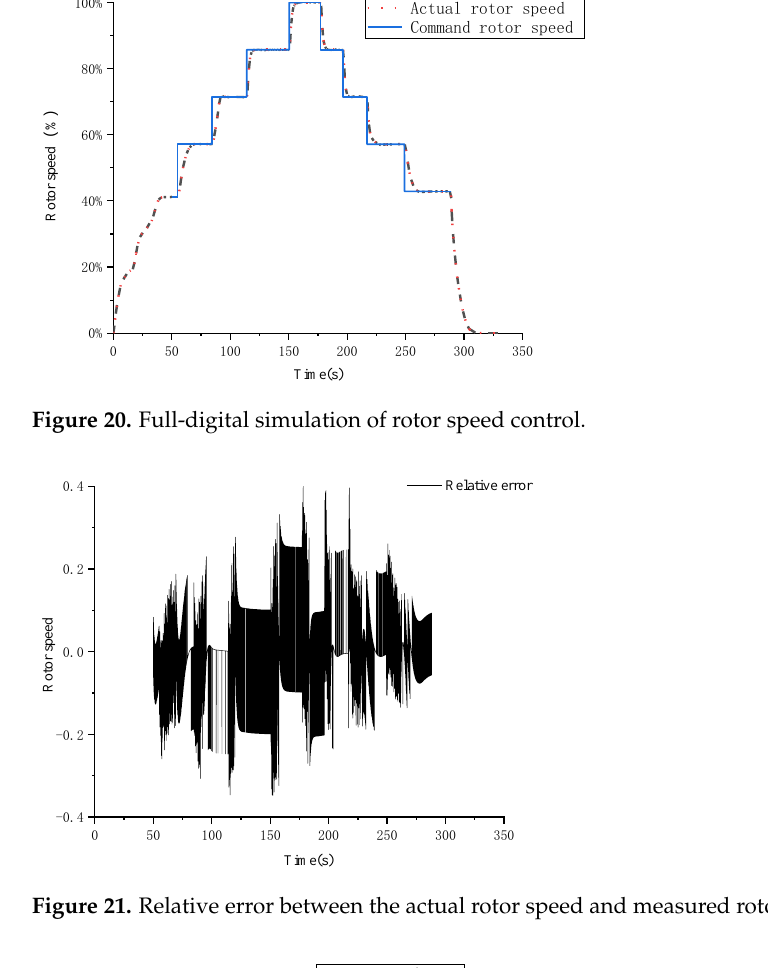
12 of 19 Figure 19. Full-Digital co-simulation (Simulink Master). The simulation results are shown in Figures 20–22. Figure 19 shows the result of the full digital simulation. The start and stop stages are under open-loop control, and the other stages are under closed-loop control. The actual speed is the feedback value of the engine model, and the measured speed is the speed calculated from the rising edge of EEC. The relative error between them is shown in Figure 20, with a maximum of no more than 0.4%. The source of the steady-state error is that there is an error of 1  counting the clock pulse when measuring the speed by the cycle measuring method. The relative error is